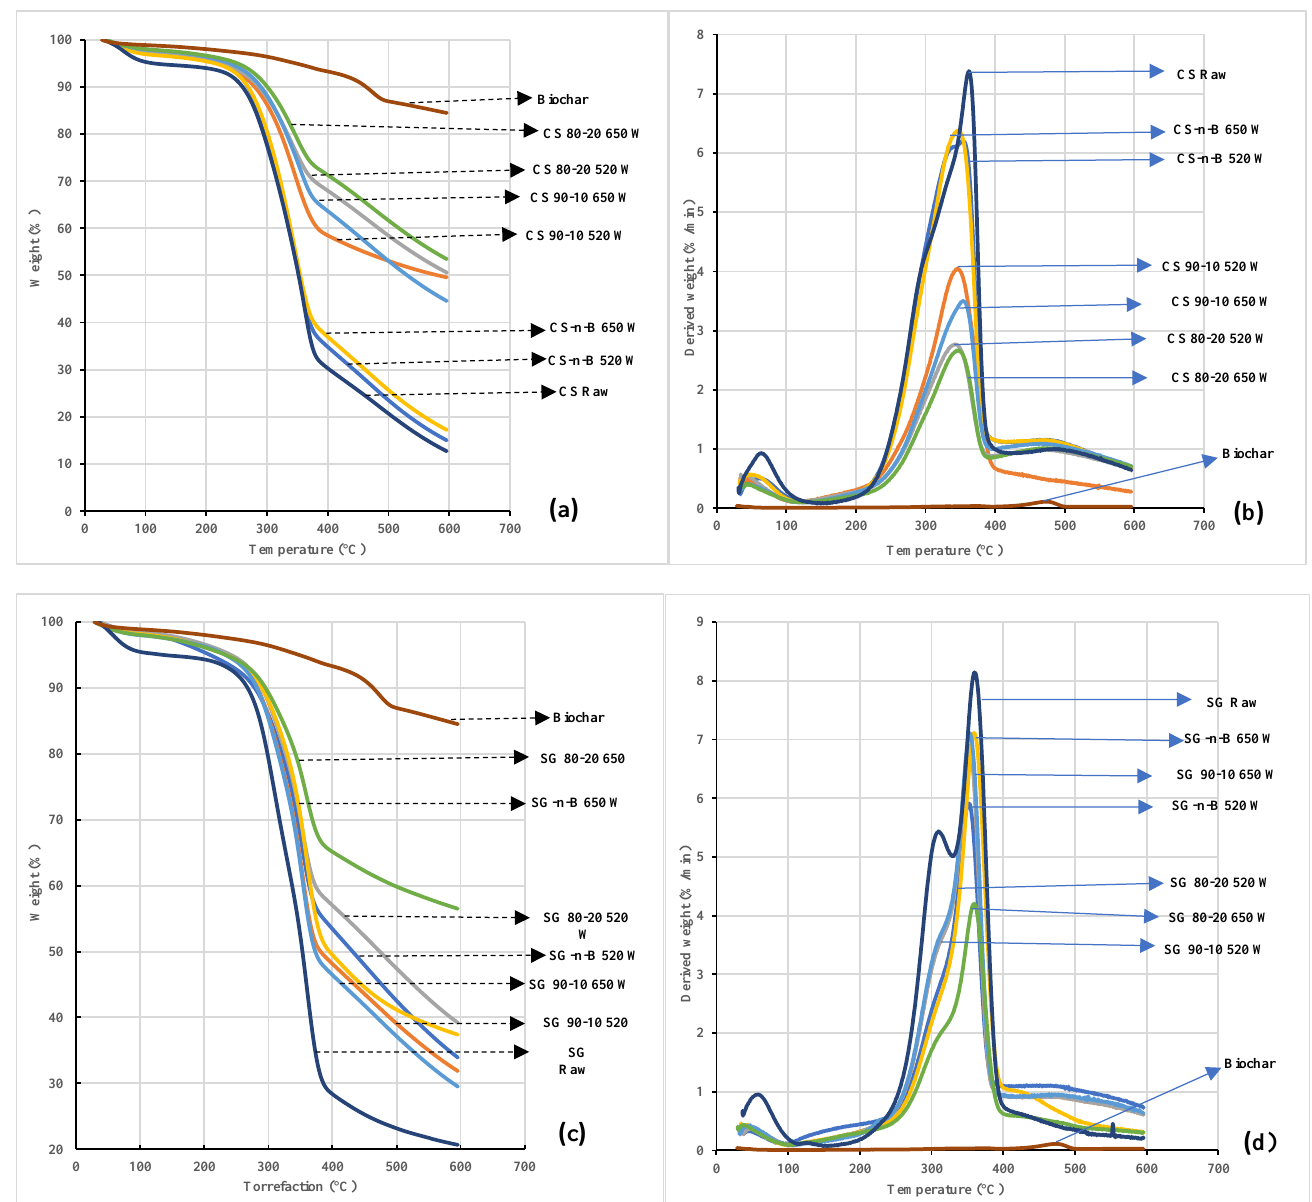
Figure 8. Thermogravimetric curves of raw and torrefied camelina straw and switchgrass with biochar-mix at 10 min residence time ( a ) TGA of CS, ( b ) DTG analyses of CS, ( c ) TGA of SG, ( d ) DTG analyses of SG. CS: camelina straw; CS-n-B: camelina straw-no-biochar; SG: Switchgrass; SG-n-B: Switchgrass-no-biochar. the first number after the biomass is % of biomass, and the second number is % of biochar. In this zone, the rate of weight loss declines gradually, forming a residue fraction; this happens due to the decomposition of lignin associated with the phenolic hydroxyl group or decomposition of inorganic carbon in the ash portion [35,36]. Additional inves- tigation is ongoing in analyzing the ash contents of both samples.